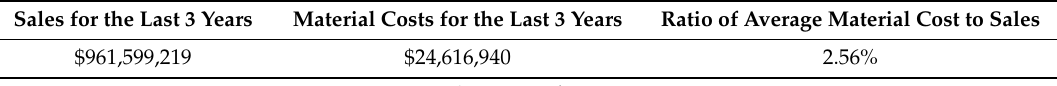
Table 4. Estimated material cost.